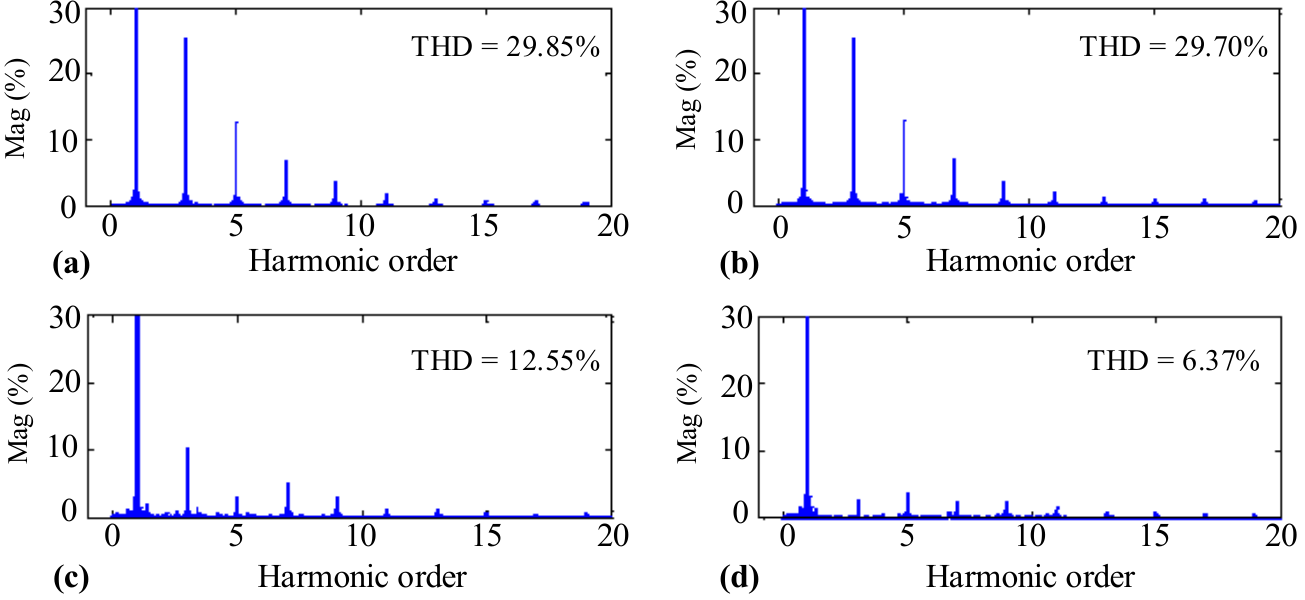
Figure 19. THD changes the output voltage in the first scenario using ( a ) the first strategy, ( b ) the second strategy, ( c ) the third strategy, and ( d ) the fourth strategy. Table 1. Comparison of steady-state values of active and reactive power in the first